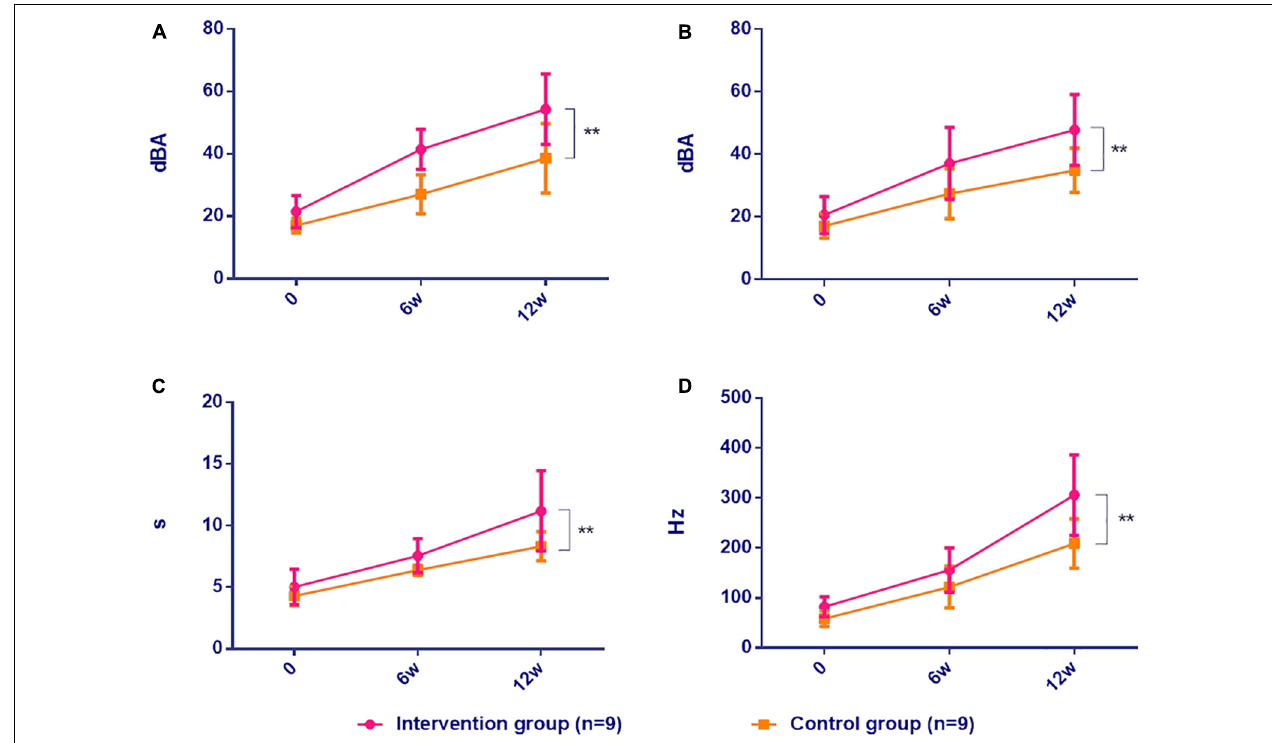
FIGURE 4 | Comparison of vocal function in CSCI patients between two groups. Intervention group: vocal intonation therapy group; Control group: respiratory photation group. (A) Sing-SPL, (B) Speech-SPL, (C) SNL, (D) F 0 . Data were expressed as mean ± SD ( n = 9) and analyzed by repeated-measures analysis of variance. * P < 0.05, ** P < 0.01. 0, baseline; 6w, after 6 weeks; 12w, after 12 weeks. Sing-SPL, sing pressure level; Speech-SPL speaks pressure level; SNL sustained note level; F0, Fundamental Frequency.